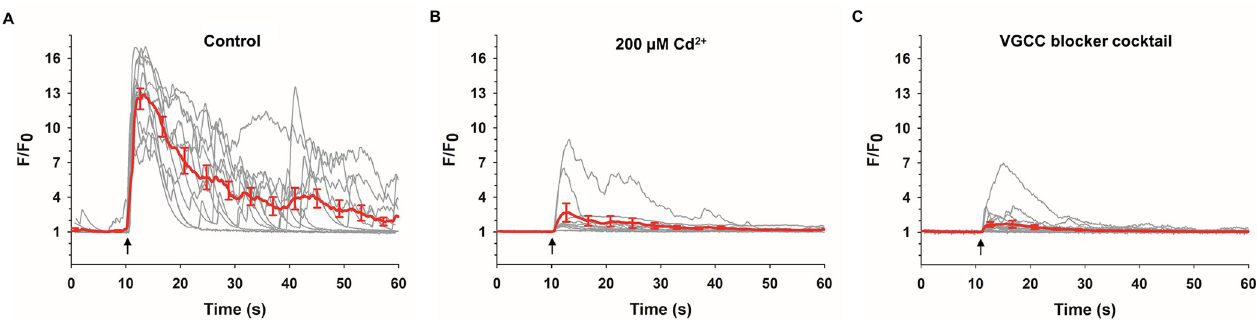
Fig 8. Effect of blocking VGCC on Ca 2+ responses evoked by a 5 ns pulse. Individual cell responses to a 5 ns, 8 MV/m pulse (arrow), together with the averaged response ± SEM (red line), in the absence (A; n = 4, c = 13) or presence of 200 μ M Cd 2+ (B; n = 2, c = 10) or presence of a cocktail of VGCC blockers consisting of 3 μ M ω -CTX GVIA, 2 μ M ω -Aga IVA, 1 μ M SNX-482, 3 μ M nifedipine (C; n = 2, c = 15).